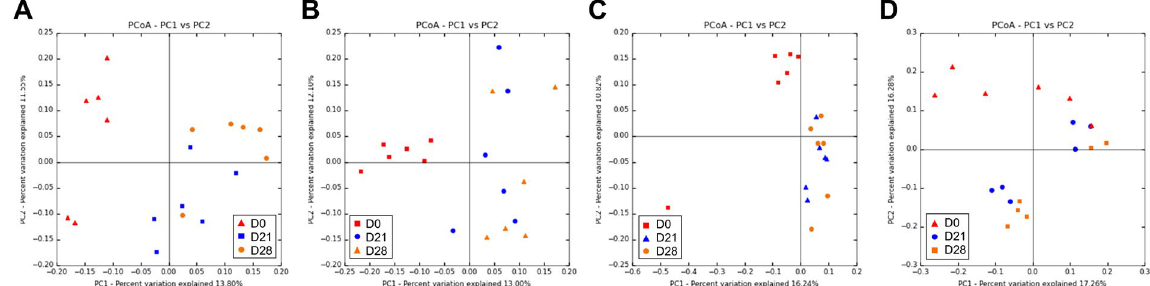
Figure 4. Evolution of the microbiota at the end of the experiment depending on the FMT strategy. Red symbols: microbiota at D0; blue symbols: microbiota at D21; orange symbols: microbiota at D28. PCoA plot showing the unweighted UniFrac distance in ( A ) Group 1 (p < 0.001); ( B ) Group 2 (p < 0.001); ( C ) Group 3 (p < 0.001); and ( D ) Group 4 (p <